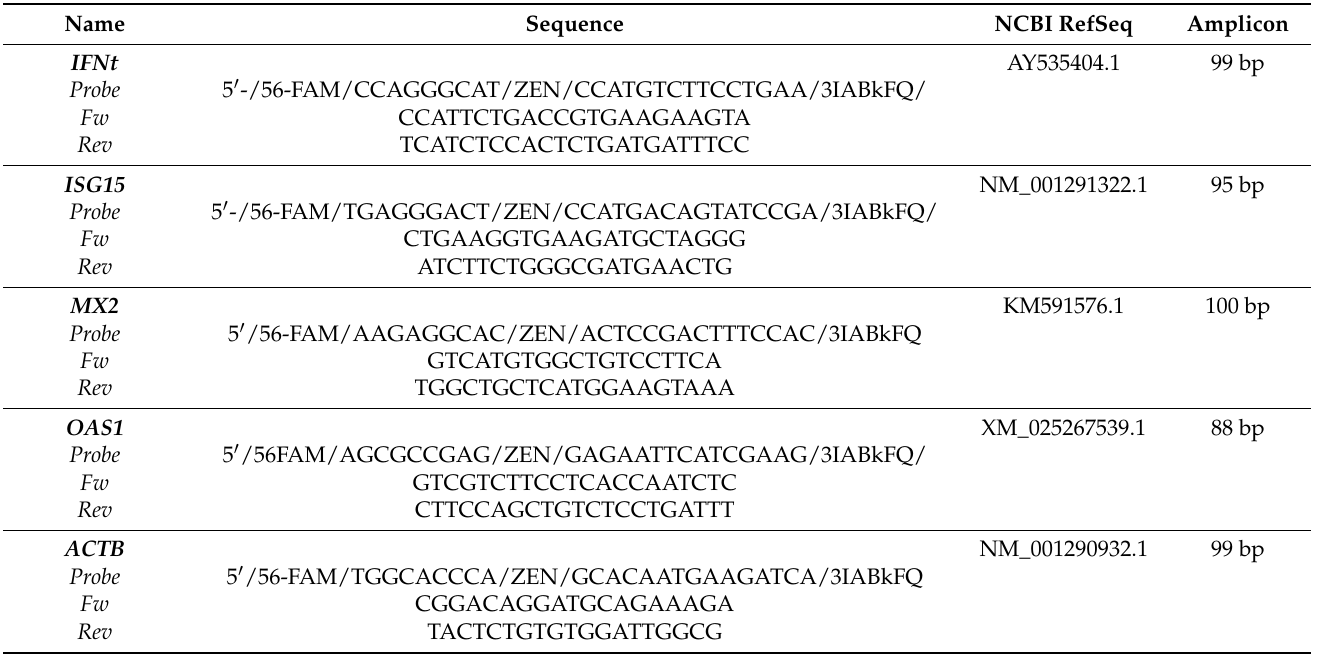
Table 1. The PrimeTime™ qPCR assays used in this study are listed. The PrimeTime™ qPCR assays are composed of a pair of unlabeled PCR primers and a probe with a 56-FAM dye label on the 5 (cid:48)